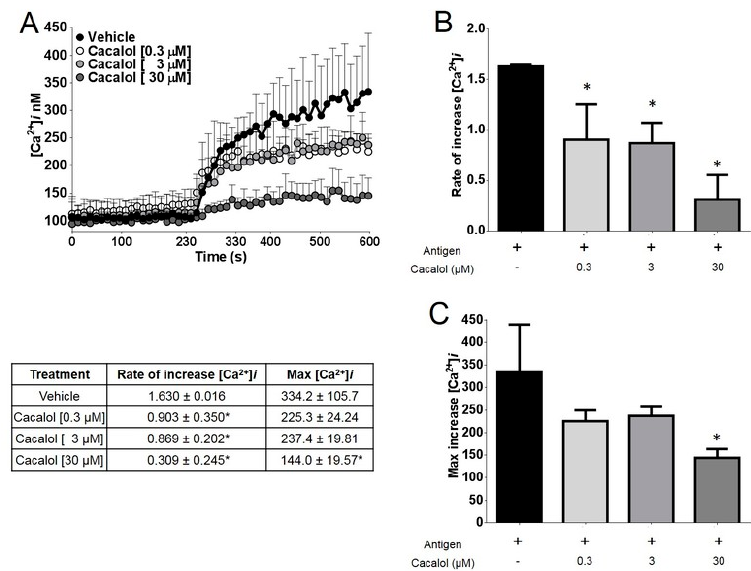
Figure 3. Cacalol inhibits intracellular calcium influx stimulated by Fc ε RI receptor in bone marrow-derived mast cells. ( A ) Representative trace of intracellular calcium rise in cells pre-treated with either vehicle or different concentrations of cacalol; ( B ) Rate of increase of [Ca 2+ ] i ; ( C ) Maximum concentration of [Ca 2+ ] i . n = 3. * p ≤ 0.05.